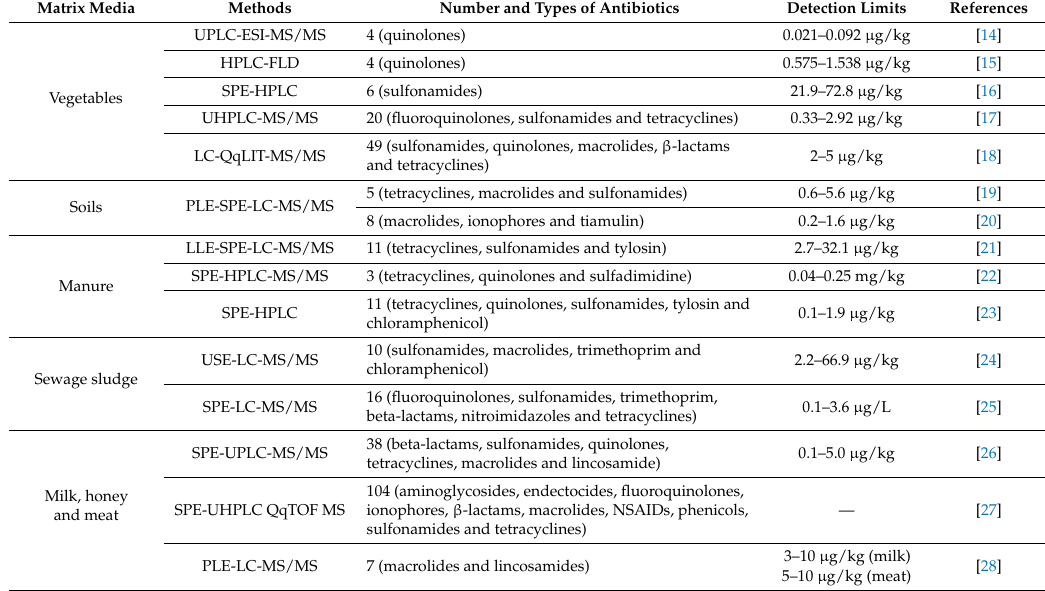
Table 1. Comparison of existing determination methods for antibiotics residues in different